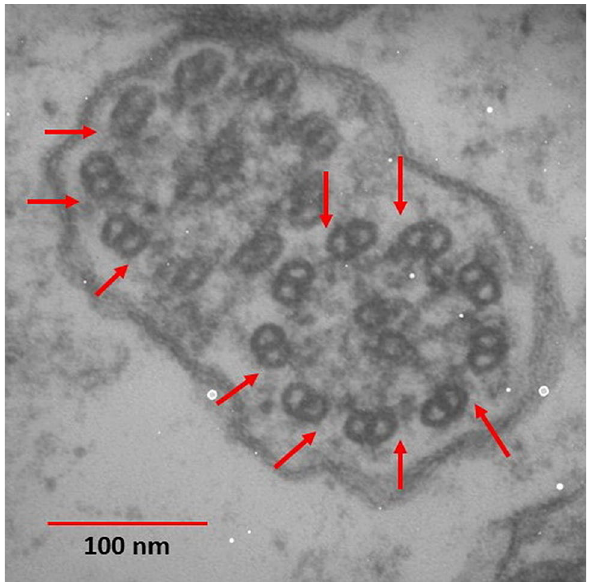
Figure 4. Compound cilia as an SCD. It should be mentioned that some primary defects like ODA defects are also evident in this picture (arrows). (Original magnification: ×140,000). ODA outer dynein